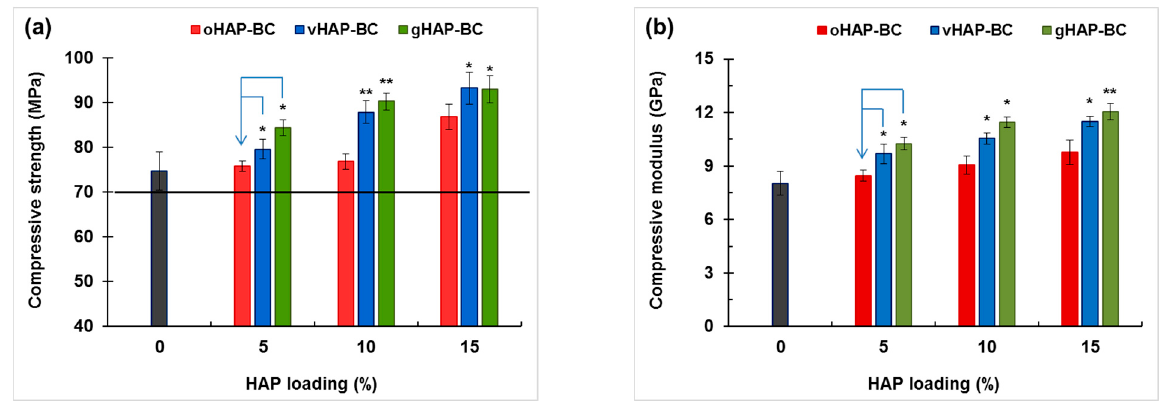
Figure 13. Compressive properties of HAP-modified bone cements as function of HAP loadings. ( a ): compressive strength and ( b ): compressive modulus. (Result = mean ± SD, n = 3; significant difference from one-tail t -test: * p < 0.05, ** p < 0.005, relative to oHAP-BCs at the same HAP loading).